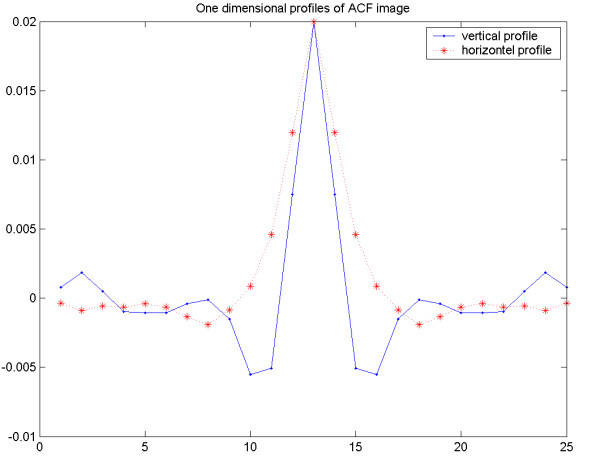
Vertical (dash point) and horizontal profile (dash star) through the centre of the ACF image obtained from the synthetic PET image